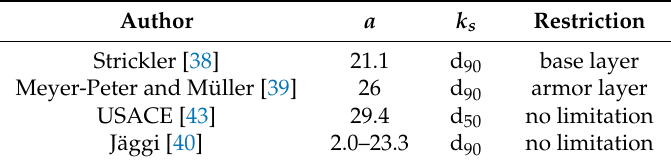
Table 1. Overview of parameters, a and k S